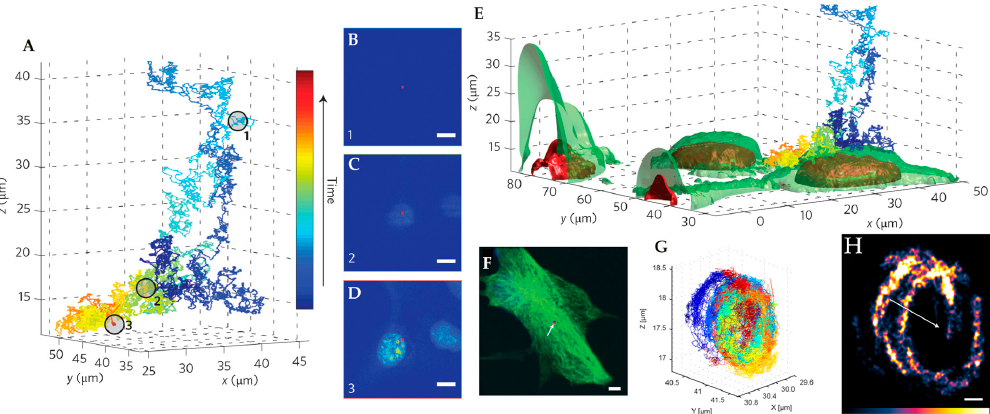
Figure 15. 3D Multi-Resolution Microscopy combines RT-3D-SPT with simultaneously acquired 2P-LSM images. ( A ) Isolated trajectory of QD-labeled nanoparticle probe. ( B – D ) Corresponding 2P-LSM sections acquired at depths indicated in circled portions of trajectory in ( A ). ( E ) Overlay of co-registered trajectory with 3D reconstruction of interpolated 2P-LSM sections gives cellular context to trajectory motion. Nuclear regions are highlighted in red and cell membrane surfaces are green. ( F ) 2P-LSM maximum intensity projection of internalized QD-labeled probe in a NIH-3T3 fibroblast cell. Arrow indicates position of tracked particle. ( G ) Ellipsoidal trajectory of macropinosomal membrane-bound probe showing multiple curved surfaces due to macropinosomal motion. ( H ) Structural tracing of the trajectory shown in ( E ). Arrow shows center of mass motion during trajectory. Adapted from reference [76] with permission of the author.